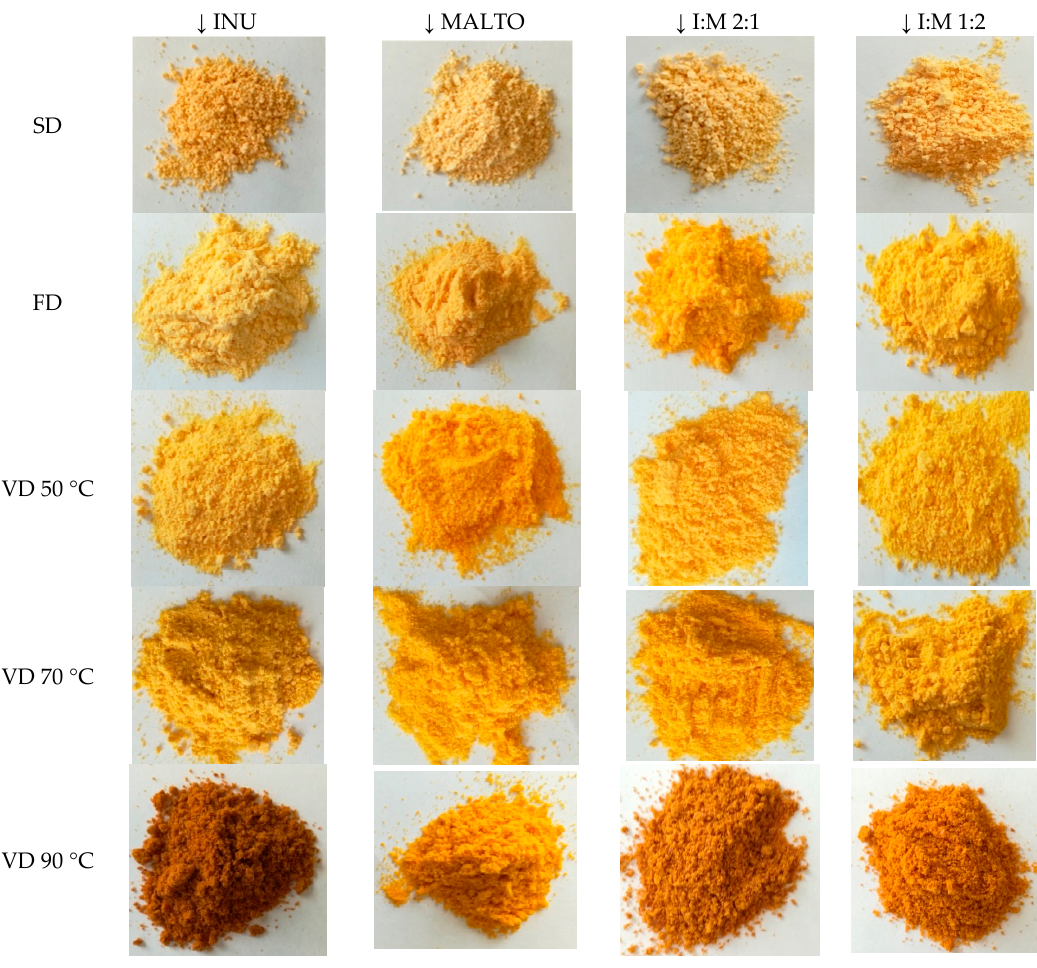
Figure 1. Color of sea buckthorn juice powders modulated by drying methods and carrier agents. SD, spray drying; FD, freeze drying; VD, vacuum drying; INU, inulin; MALTO, maltodextrin; I:M, inulin:maltodextrin.